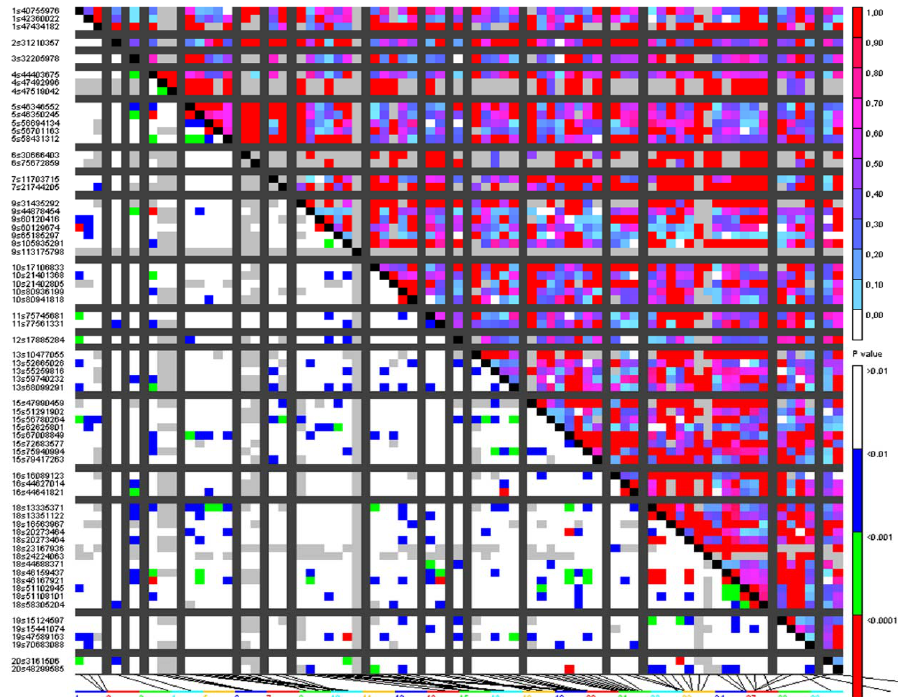
Figure 6. Heatmap representing variation in linkage disequilibrium (LD) on outlier loci distributed on Salmo salar chromosomes: The markers were presented on the x and y axes according to their chromosomal positions. The D’ values are denoted by a color scale from white (0.0) to dark red (1.0) in the upper triangle. The p ‐ values ranging from nonsignificant (>0.01; white) to highly significant (<0.0001; red) are shown in the lower triangle.